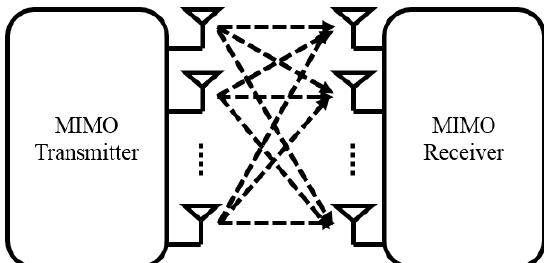
Figure 1. Multiple input and multiple output based on orthogonal frequency division multiplexing (MIMO-OFDM)